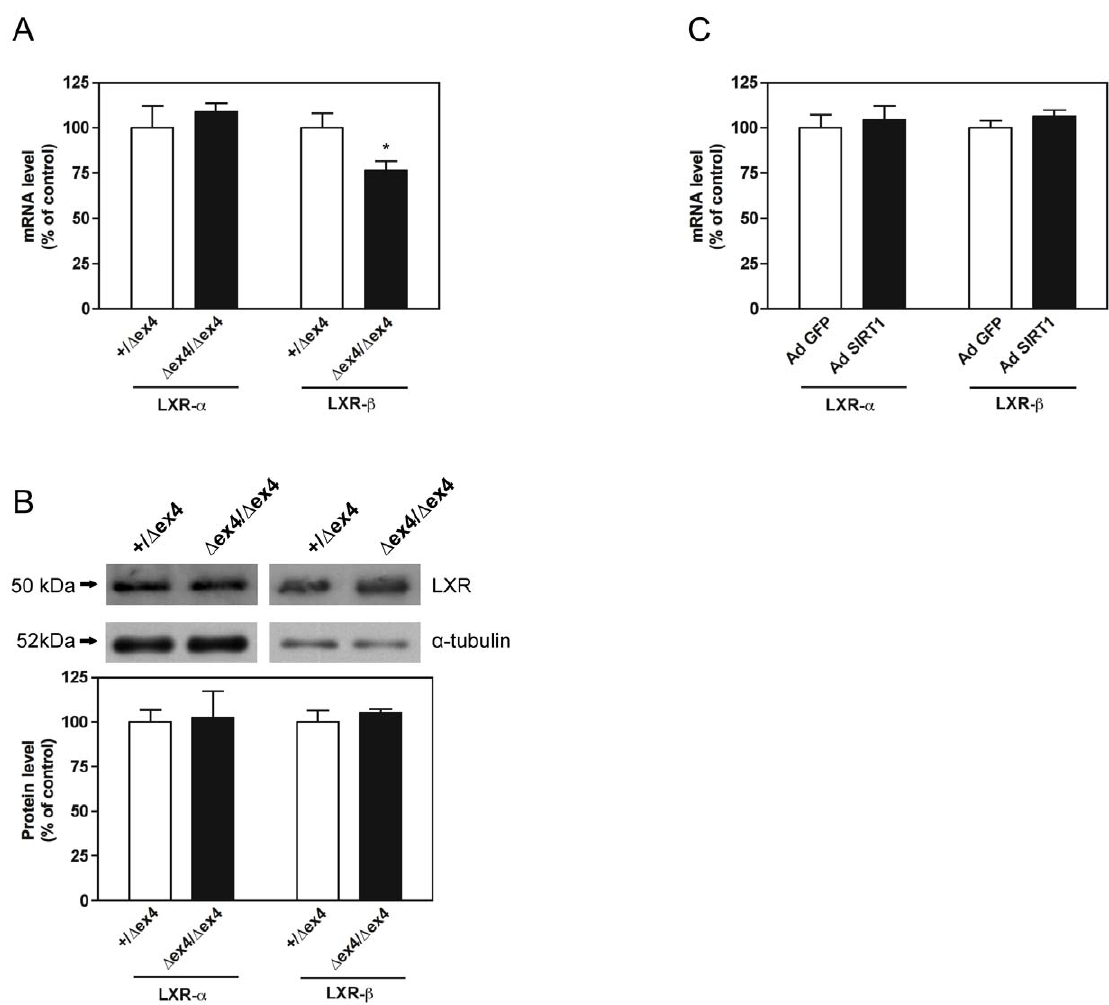
Figure 2. Liver X receptor (LXR)- a and LXR- b expression. (A) LXR- a and LXR- b mRNA level in the gastrocnemius muscle of SIRT1 + / D ex4 and SIRT1 D ex4/ D ex4 mice. (B) LXR- a and LXR- b protein level in the gastrocnemius muscle of SIRT1 + / D ex4 and SIRT1 D ex4/ D ex4 mice. (C) LXR- a and LXR- b mRNA level in human myotubes (7 days of differentiation) infected for 48 hours with recombinant adenovirus expressing either green fluorescent protein (AdGFP) or sirtuin 1 (AdSIRT1). For western blot analysis, equal protein loading was controlled by measuring total protein content and a -tubulin expression by western blot. Data are expressed as means 6 SE (n=4/group for animal study; n=8/group for in vitro study). * P , 0.05: significantly different from SIRT1 + / D ex4